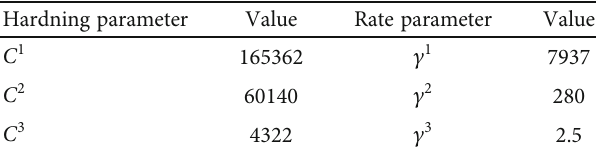
Table 3: Chaboche elasto-plastic model